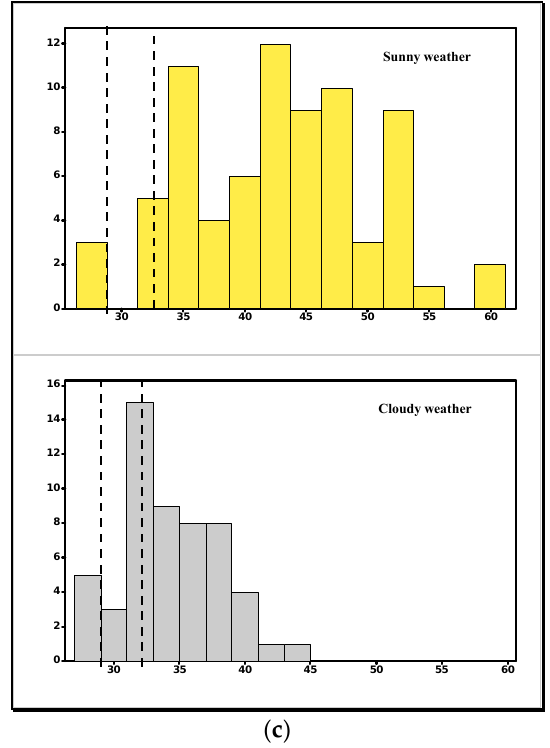
Figure 5. Histograms of model temperatures placed in ( a ) shaded locations, ( b ) partially shaded locations, and ( c ) sunny locations. Vertical broken lines represent set point body temperature ranges.